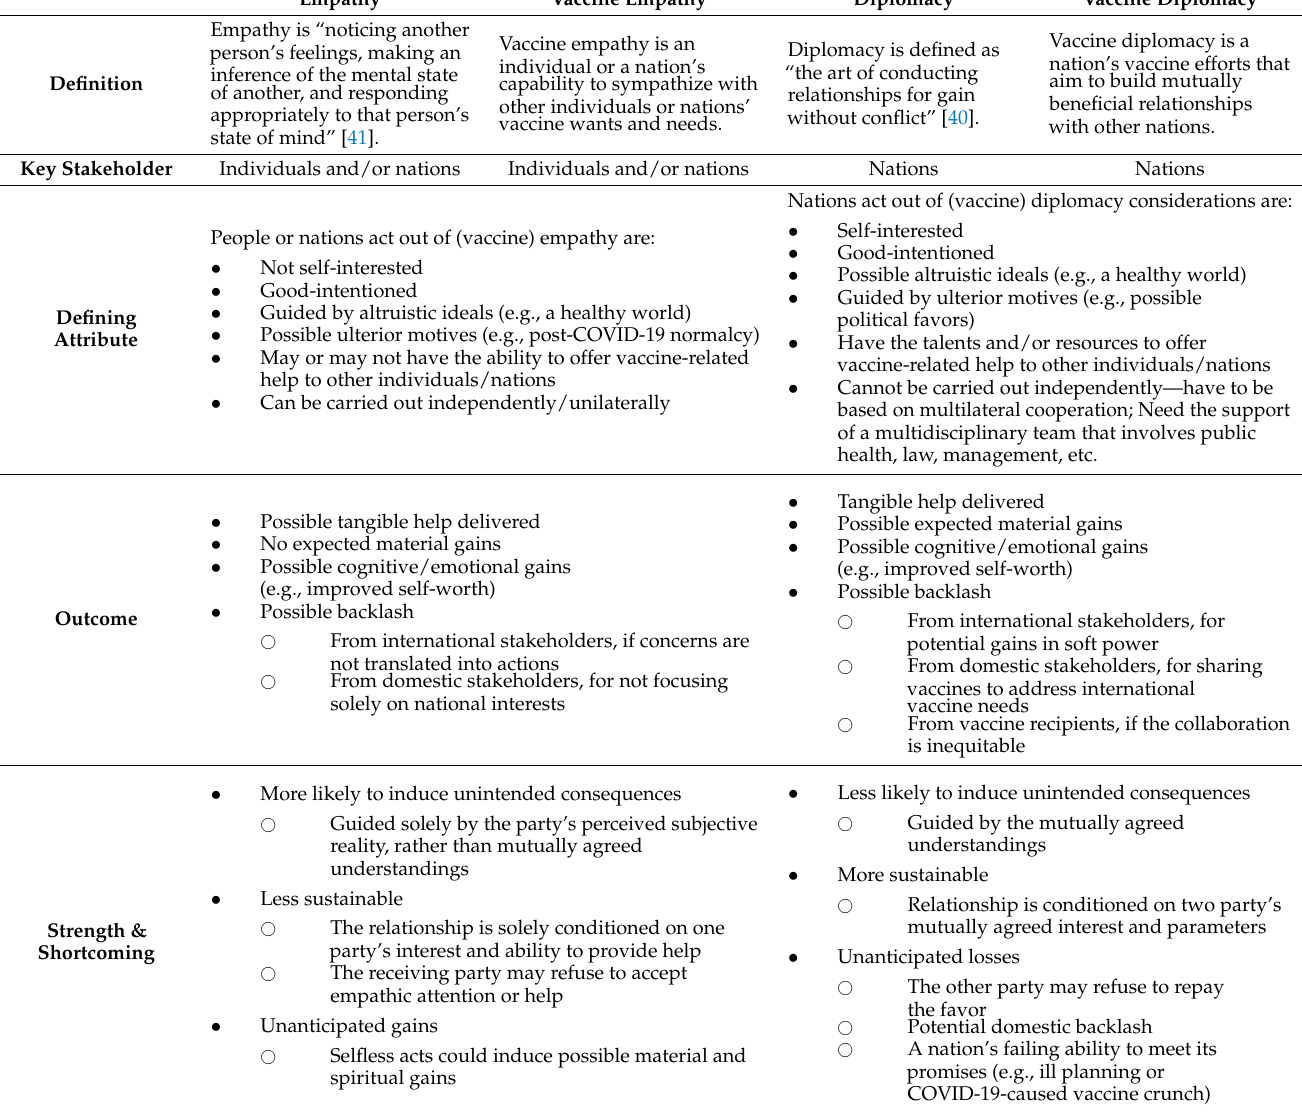
Table 4. Definitions and defining characteristics of vaccine empathy and vaccine diplomacy. Empathy Vaccine Empathy Diplomacy Vaccine